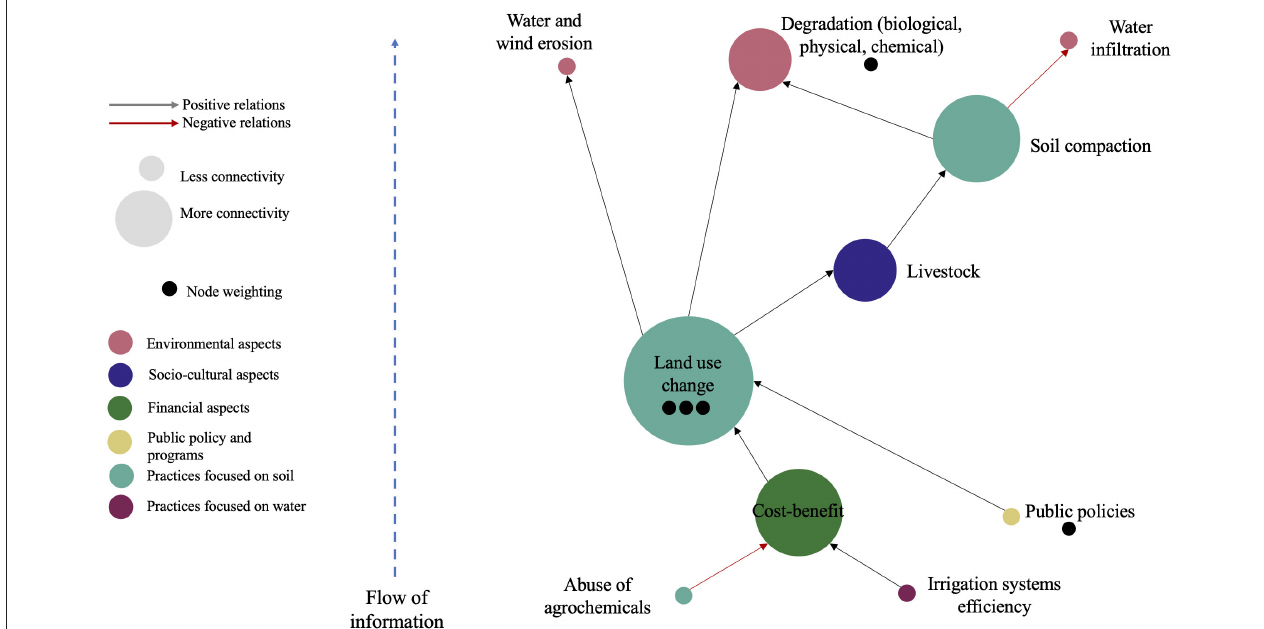
FIGURE 8 | Top ten nodes for the FG CM based on centrality measures. Size of the nodes correspond to connectivity. Black dots represent the weighting scores.